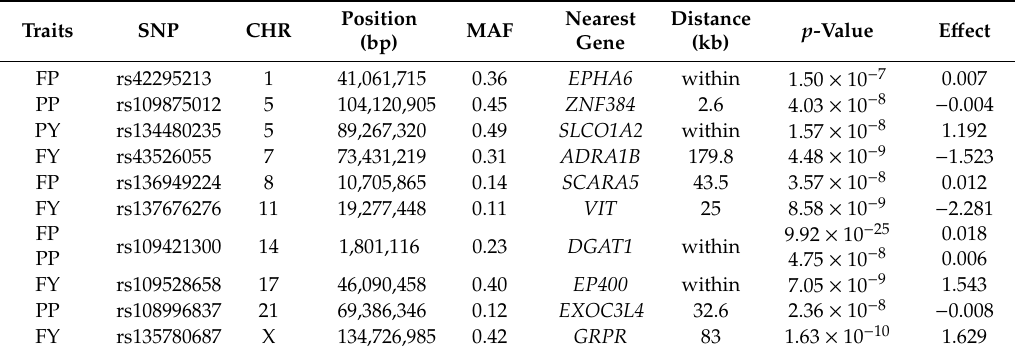
Table 2. Genome-wide significant SNPs associated with milk traits